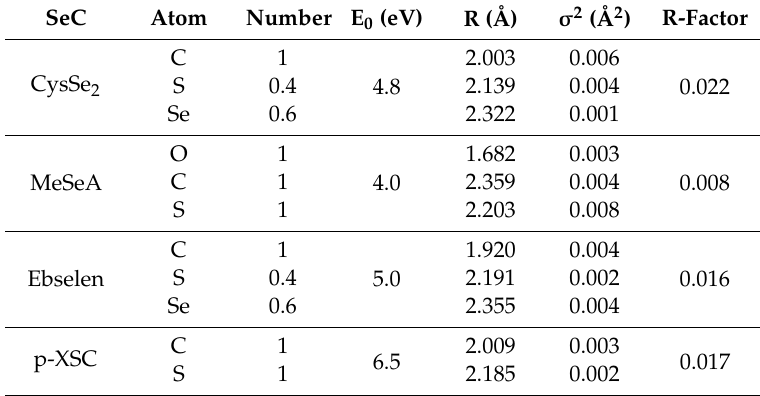
Figure 3. X-ray absorption spectroscopy measurements. ( a ) X-ray absorption near edge spectra of SeC, SeC–BSA, and SeC–FBS. ( b ) Extended X-ray absorption fine structure of SeC, SeC–BSA, and SeC–FBS. ( c ) Pseudo-radial distribution functions of the extended X-ray absorption fine structure for SeC–BSA and SeC–FBS. Experimental spectra of SeC, SeC–BSA, and SeC–FBS are represented as black, red, and green lines, respectively. The blue line in panel ( c ) marks the best fit of the SeC–FBS spectrum. Table 1. Fitting results of the spectra of SeC–FBS considering the Se–S bond in the model. The k-range used was 2.5–13.0 Å -1 . The amplitude reduction factor (S 02 ) was fixed to 0.85.